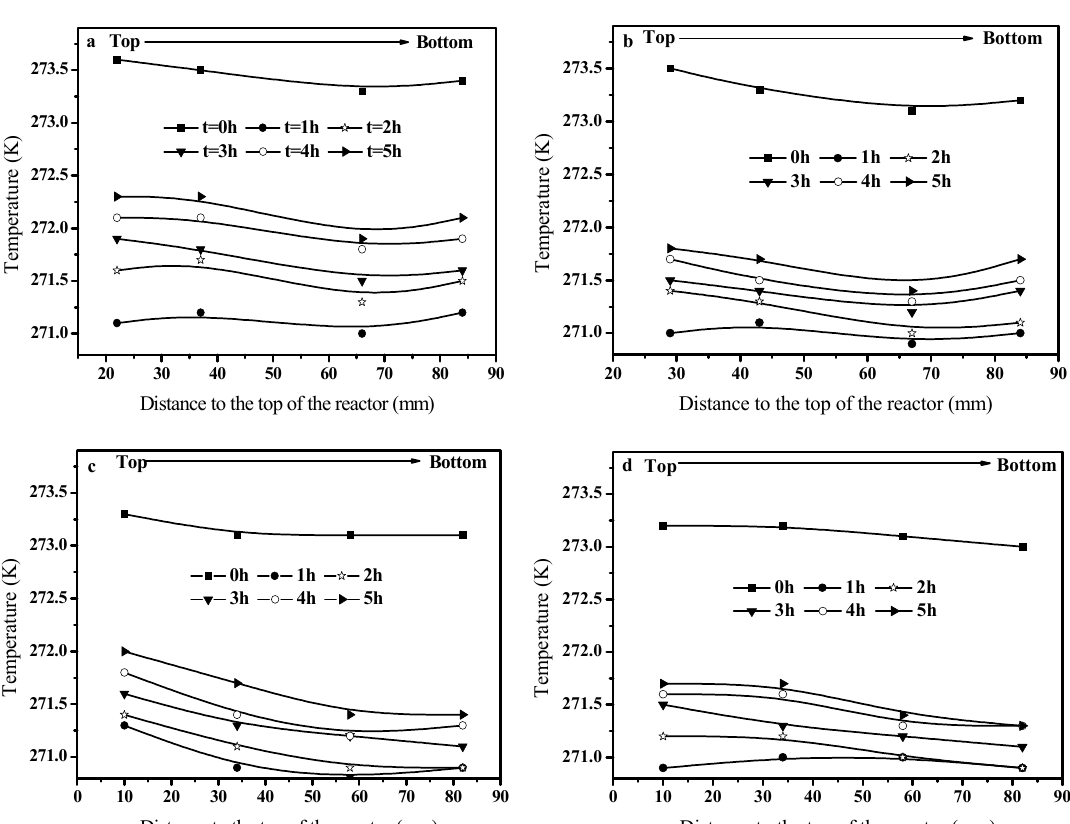
Figure 4. Temperature distributions and their evolution with elapsed time [62]: ( a ) profiles with the same radius of 132 mm; ( b ) profiles with the same radius of 99 mm; ( c ) profiles with the same radius of 66 mm; ( d ) profiles with the same radius of 33